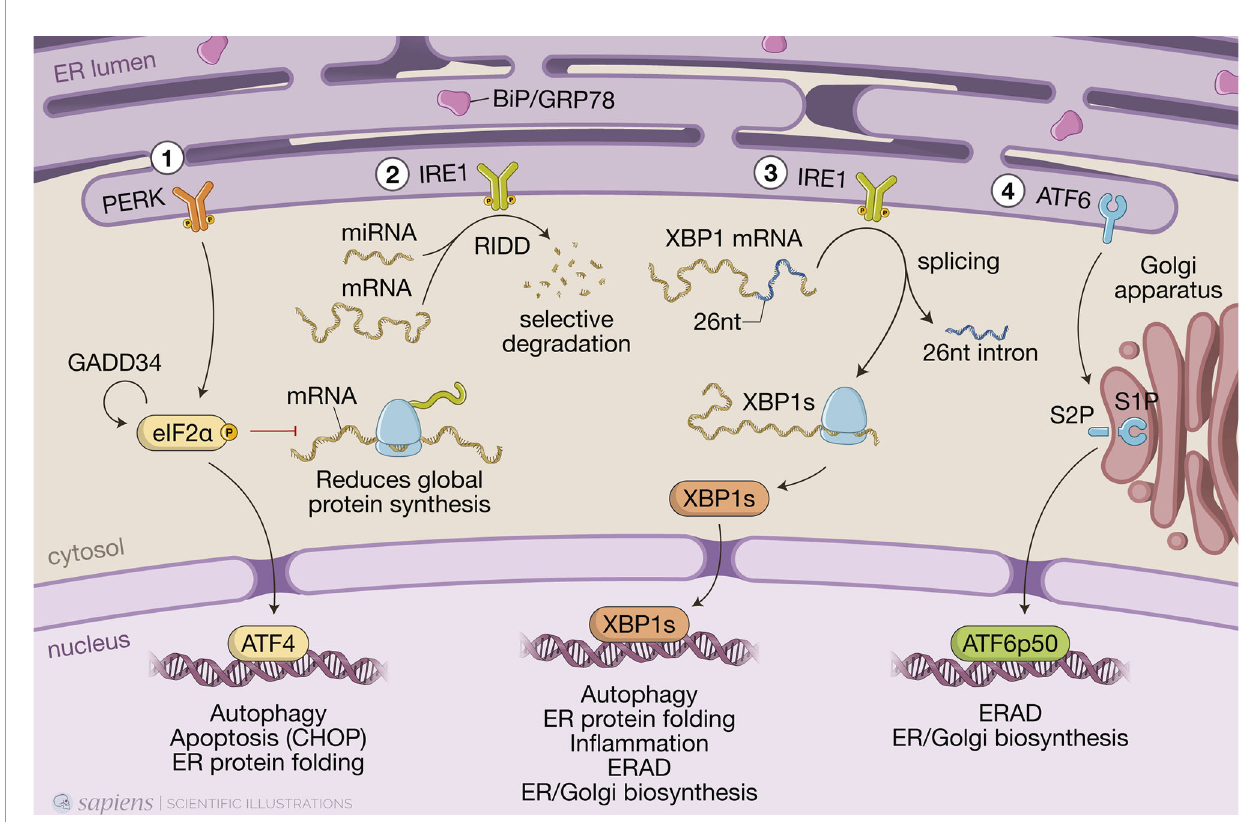
FIGURE 1 | The three branches of the unfolded protein response (UPR). When misfolded proteins accumulate in the endoplasmic reticulum (ER) lumen, chaperone binding immunoglobulin protein (BiP/GRP78) is detached from the luminal domains of the three ER sensors to which it was bound, allowing PKR-like ER protein kinase (PERK) and inositol-requiring protein-1 (IRE1) to form homodimers and activating transcriptional factor-6 (ATF6) to transit to the Golgi. (1) PERK phosphorylates the a -subunit of the eukaryotic translation initiation factor 2 (eIF2 a ), resulting in a global reduction of protein synthesis while still maintaining translation of a few key proteins, such as activating transcription factor 4 (ATF4), which induces expression of genes involved in redox homeostasis, amino acid metabolism, protein synthesis, autophagy and apoptosis, such as the transcription factor C/EBP homologous protein (CHOP). Protein synthesis is restored when eIF2 a is dephosphorylated by protein phosphatase 1 (PP1) regulatory subunit GADD34, which is also induced by ATF4 when ER stress is resolved. (2) IRE1 autophosphorylates to switch on its RNase activity, inducing a process known as regulated IRE1-dependent decay (RIDD), in which IRE1 cleaves and leads to the selective degradation of a small set of mRNAs or miRNAs. (3) IRE1 also excises a short 26-nucleotide intron from the mRNA encoding transcription factor X-box- binding protein 1 (XBP1), generating the spliced Xbp1 mRNA, which is ultimately translated into the transcription factor XBP1s that, like ATF4, upregulates genes involved in multiple cell signaling pathways, such as ER-associated protein degradation (ERAD). (4) Full length ATF6 translocates from the ER to the Golgi, where it is cleaved by site-1 protease (S1P) and site-2 protease (S2P). This releases a cytosolic fragment which then transits to the nucleus, transcription factor ATF6p50, which drives a transcriptional program to reestablish